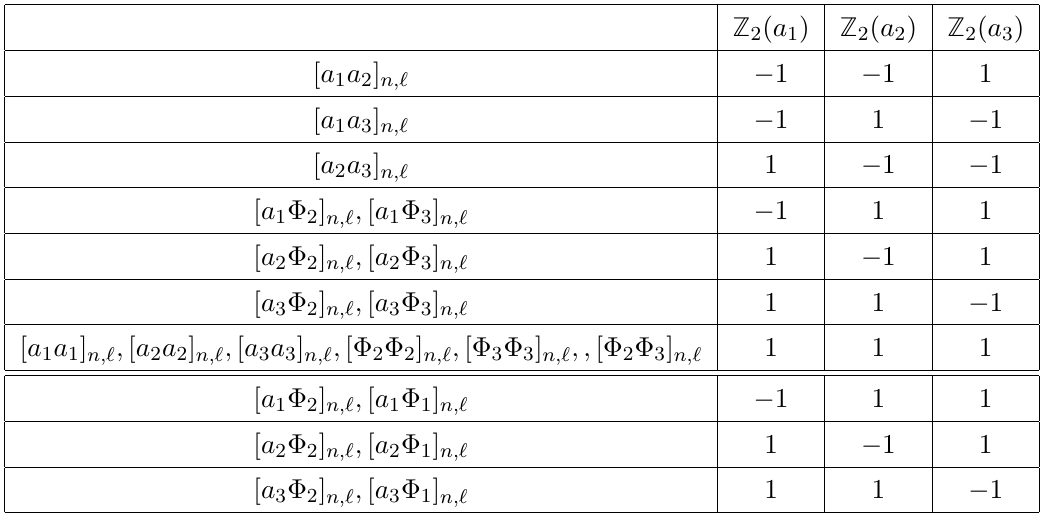
Table 2 . Irreducible representation of the double trace operators under the Z 2 × Z 2 × Z 2 symmetry. The two different blocks correspond to distinct subspaces, where the degeneracies are partly broken by the discrete